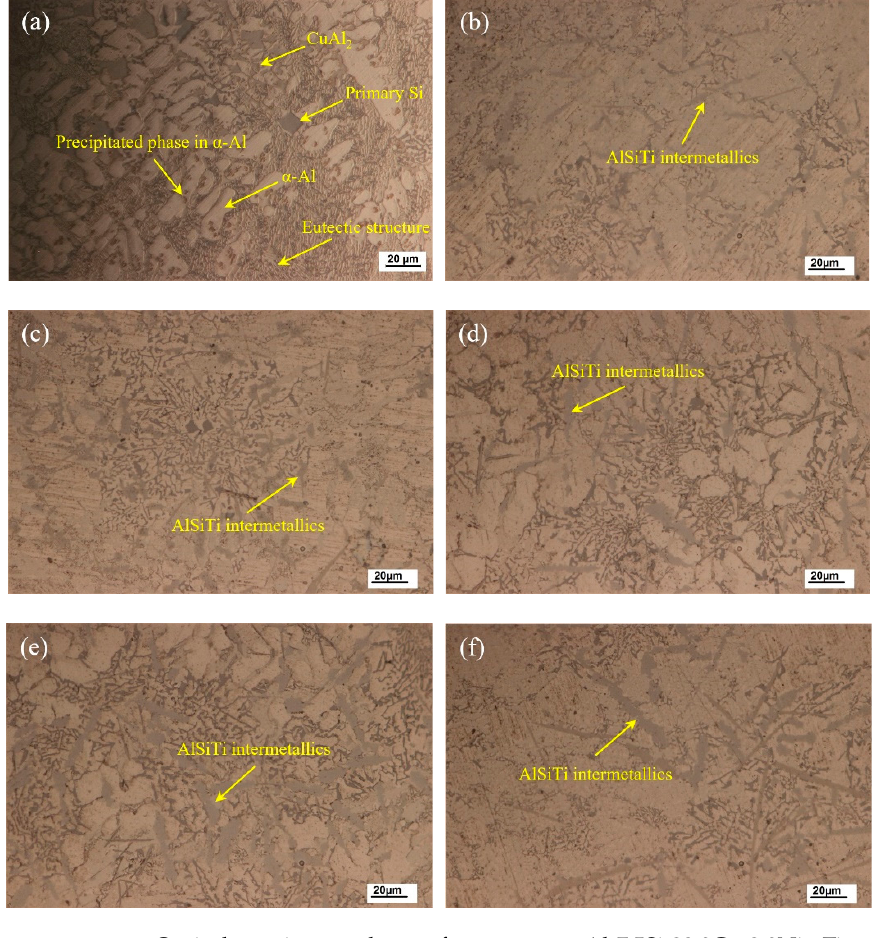
Figure 3. Optical micrographs of as-cast Al-7.5Si-23.0Cu-2.0Ni-xTi alloys: ( a ) Al-7.5Si-23.0Cu-2.0Ni-0.0Ti; ( b ) Al-7.5Si-23.0Cu-2.0Ni-0.5Ti; ( c ) Al-7.5Si-23.0Cu-2.0Ni-1.0Ti; ( d ) Al-7.5Si-23.0Cu-2.0Ni-1.5Ti; ( e ) Al-7.5Si-23.0Cu-2.0Ni-2.0Ti; ( f ) Al-7.5Si-23.0Cu-2.0Ni-2.5Ti.